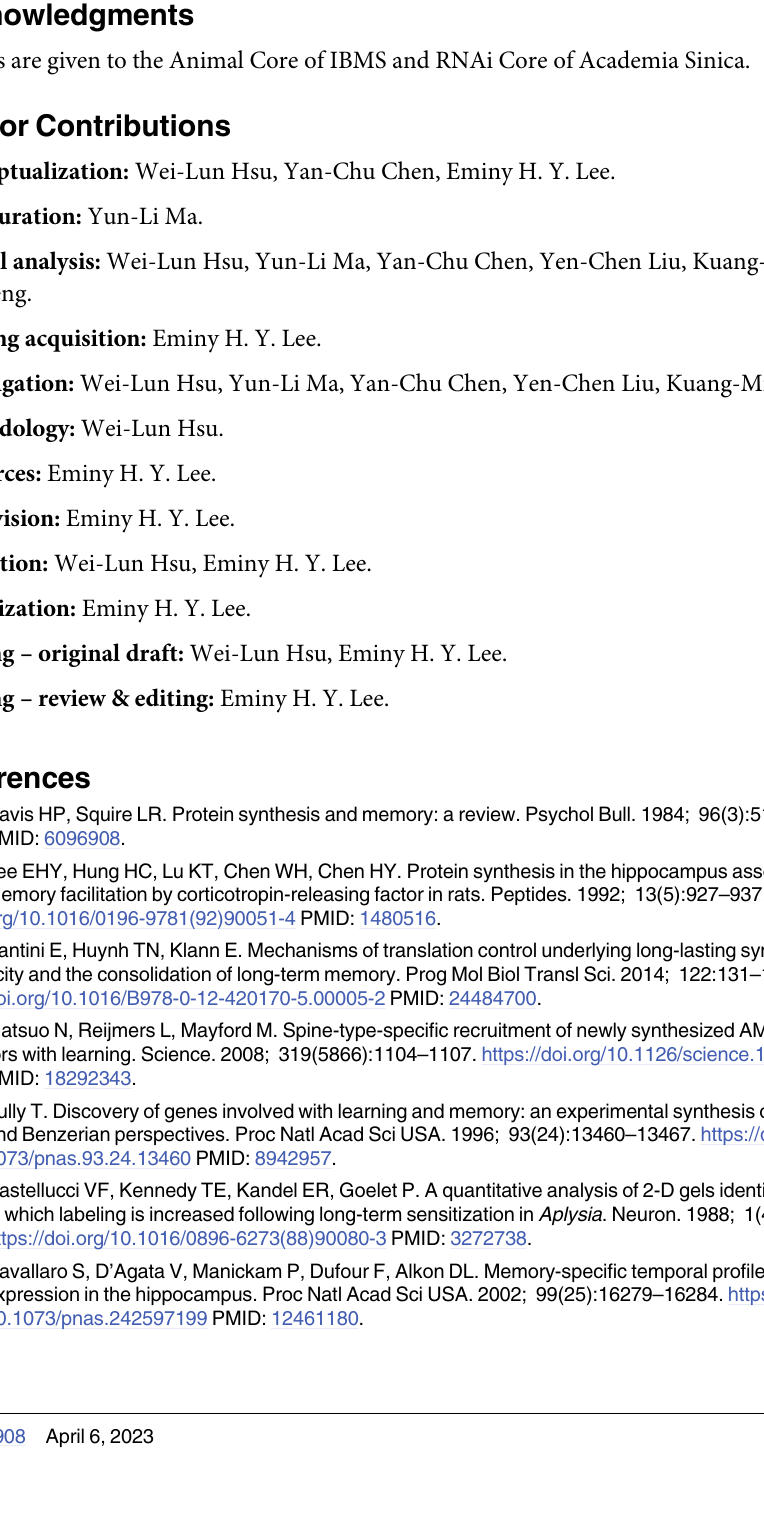
S5 Fig. Ndfip1 expression level is not different between wild-type (WT) mice and Ndfip1 flox/WT